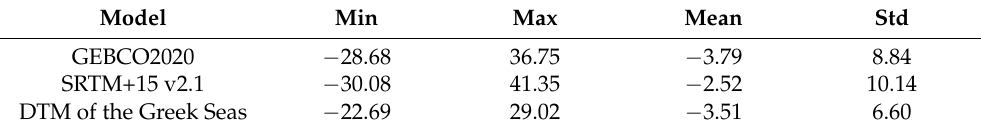
Table 5. Statistics of differences between in situ depths measurements and bathymetry models. (m.)